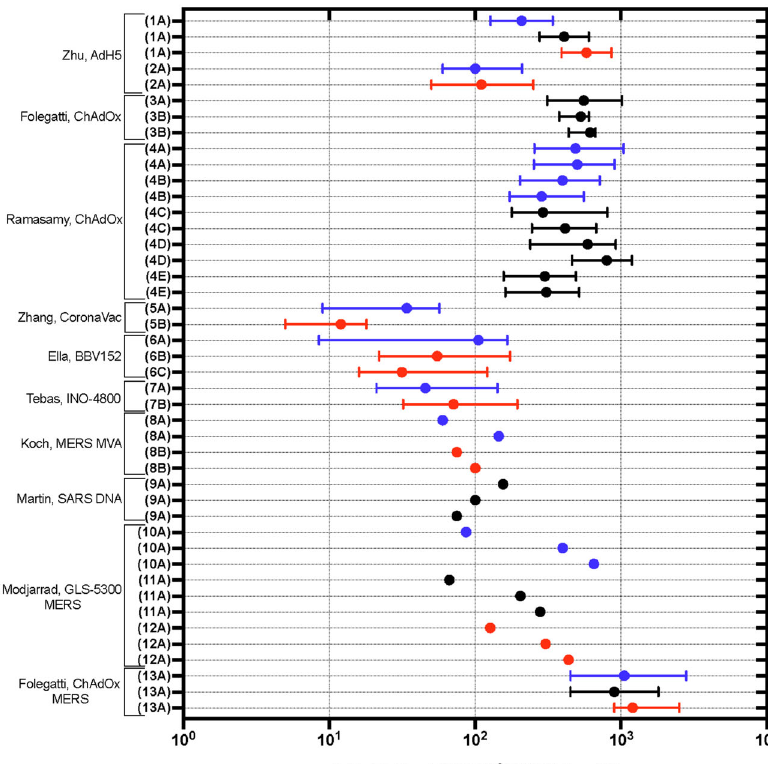
Fig. 8 Forest plot of IFN γ ELISpot T cell response following HCoV vaccination in human studies. Blue = low; black = intermediate; red = high dose of vaccine indicated. IFN γ ELISpot data recorded circa 28 days post injection. Log transformed scale used. Vp viral particles, GMT geometric mean, CI con fi dence interval, IQR interquartile range. ( 1A ) Zhu, AdH-5 Phase 1: low dose — 5 × 10 10 vp, intermediate dose — 1 × 10 11 vp, high dose — 1.5 × 10 11 vp; expressed as IFNy expressing cells/10 6 PBMC (95% CI); ( 2A ) Zhu, AdH-5 Phase 2: low dose — 1 × 10 11 vp, high dose — 5 × 10 10 vp; expressed as IFNy expressing cells/10 6 PBMC (95% CI); ( 3A , B ) Folegatti, ChAdOx SARS-CoV-2: unspeci fi ed dose — 5 × 10 10 vp; ( A ) Prime only, ( B ) Prime-Boost; expressed as SFC/10 6 PBMC (95% CI); ( 4A – E ) Ramasamy, ChAdOx: low dose — 2.2 × 10 10 vp, unspeci fi ed dose — 3.5 – 6.5 × 10 10 vp; ( A ) Prime-Boost, 56 – 69 y/o (low), ( B ) Prime-Boost, ≥ 70 y/o (low), ( C ) Prime-Boost, 18 – 55 y/o (unspeci fi ed), ( D ) Prime- Boost, 56 – 69 y/o (unspeci fi ed), ( E ) Prime-Boost, ≥ 70 y/o (unspeci fi ed); expressed as SFC/10 6 PBMC (IQR); ( 5A , B ) Zhang, CoronaVac, Phase